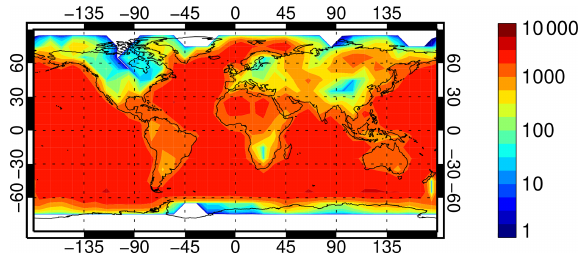
Figure 1. Number of SSMIS F-17 observations (superobs) selected in the 13–22 June 2019 study period per 10 ◦ by 10 ◦ latitude– longitude bin. The colour scale is logarithmic to highlight data-poor areas. White areas have no observations. A total of 916258 obser- vations are